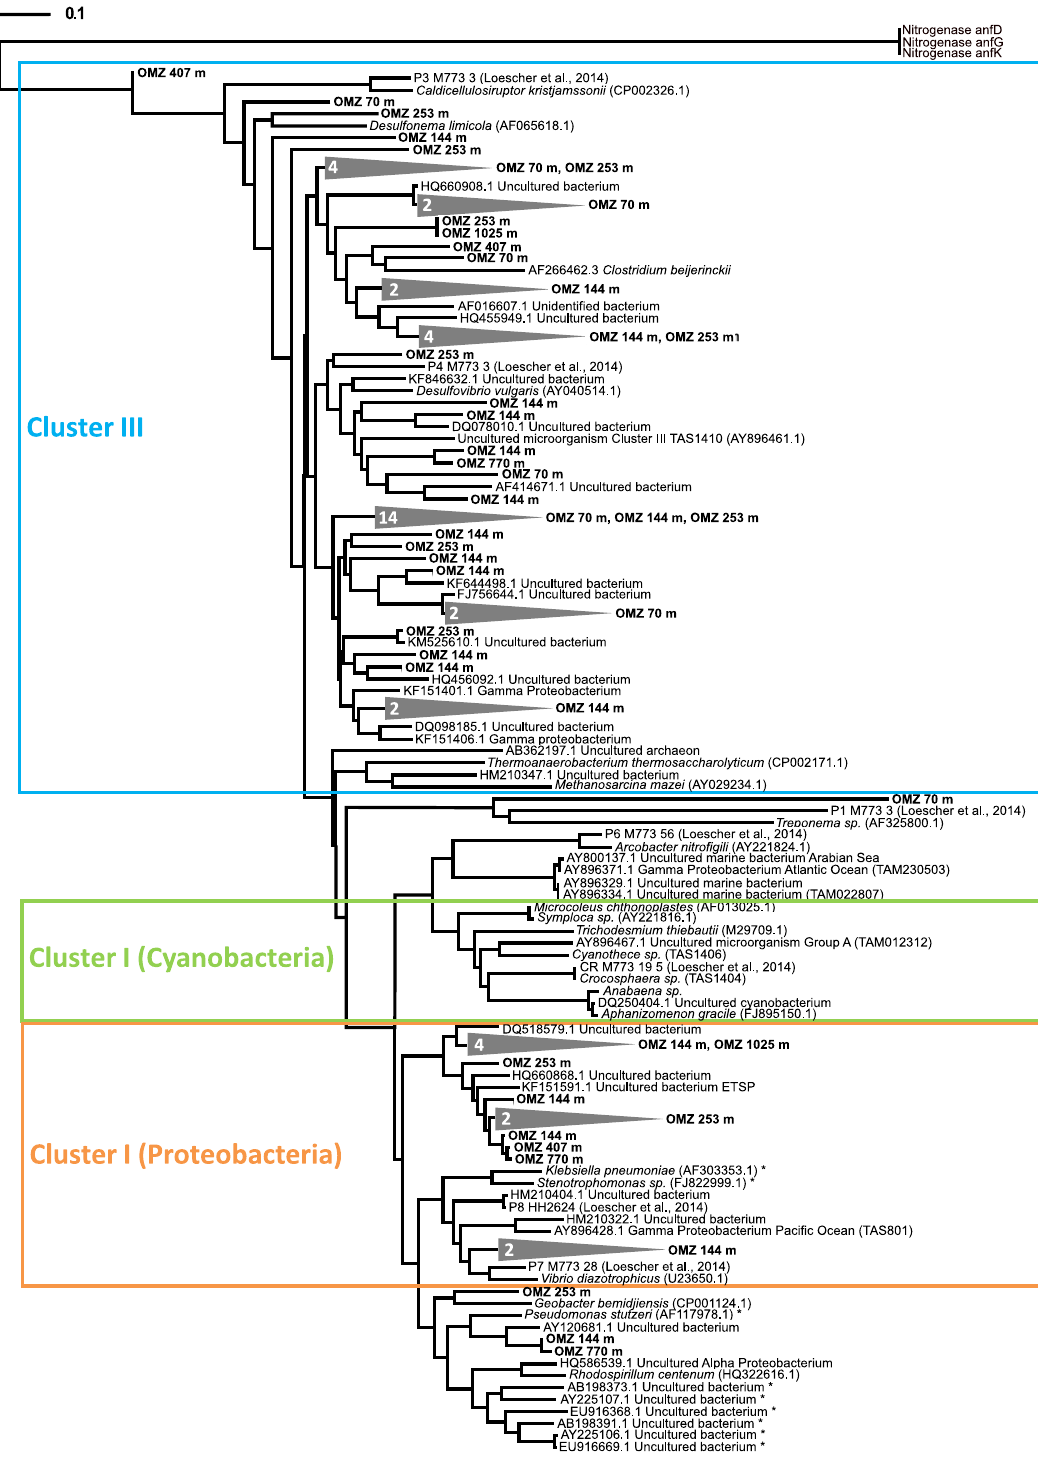
Figure 7. Phylogenetic tree of nifH genes based on the analysis of 122 sequences ( ∼ 20 sequences per sample) from the six sampling stations between 70 and 1025m water depth. Novel detected clusters consisting of several sequences from the same sampling depth are indicated by grey triangles. Reference sequences consist of the alternative nitrogenase anf D , anf G , anf K . Cluster III sequences as defined by Zehr and Turner (2001) are highlighted in blue; Cluster I cyanobacterial sequences are highlighted in green and Cluster I proteobacterial sequences are highlighted in orange. The scale bar indicates the 10% sequences divergence. Sequences marked with an asterisk represent potential PCR contaminated products, with novel clusters distant from those clusters. Sequences determined in this study are termed OMZ plus the corresponding water